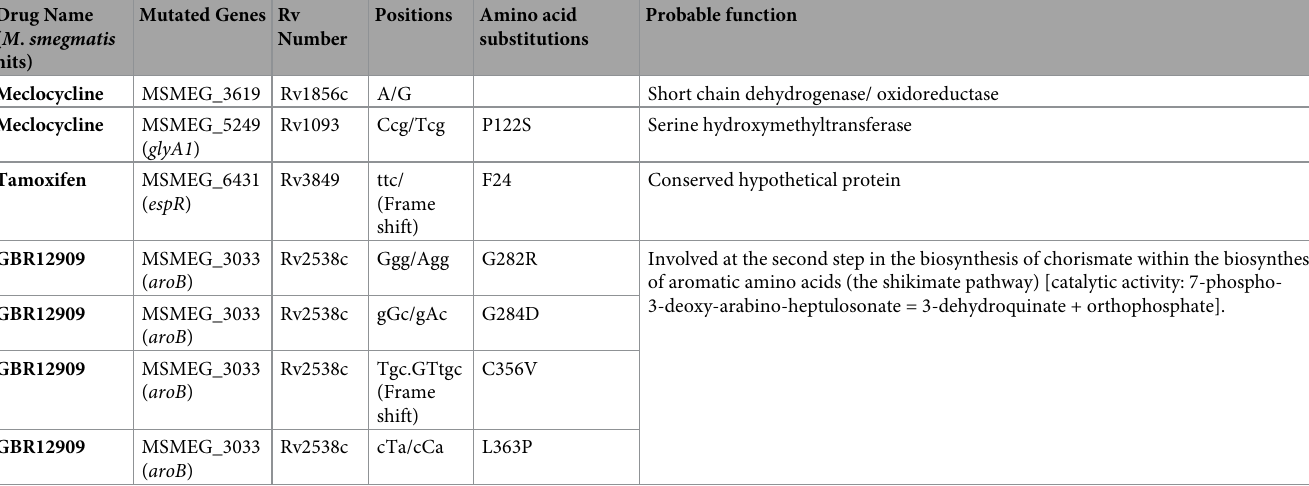
The table represents the single nucleotide polymorphisms obtained through whole genome sequencing of the spontaneous resistant mutants raised compared against drug sensitive M . smegmatis